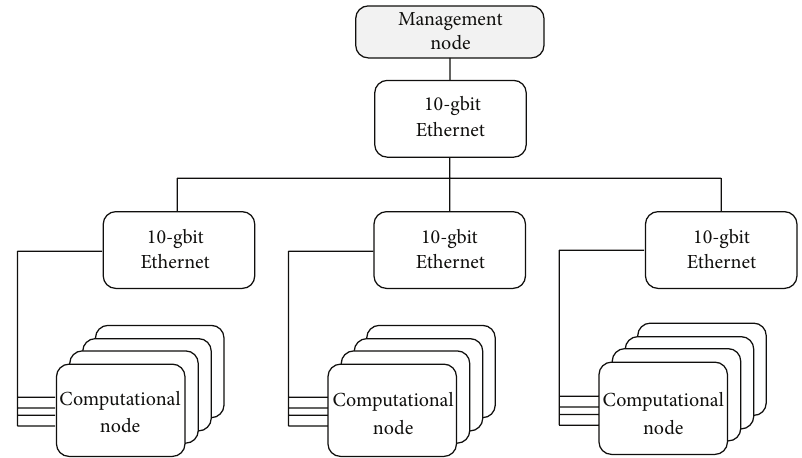
Figure 1: Infrastructure composed of several computational nodes managed by a management node.